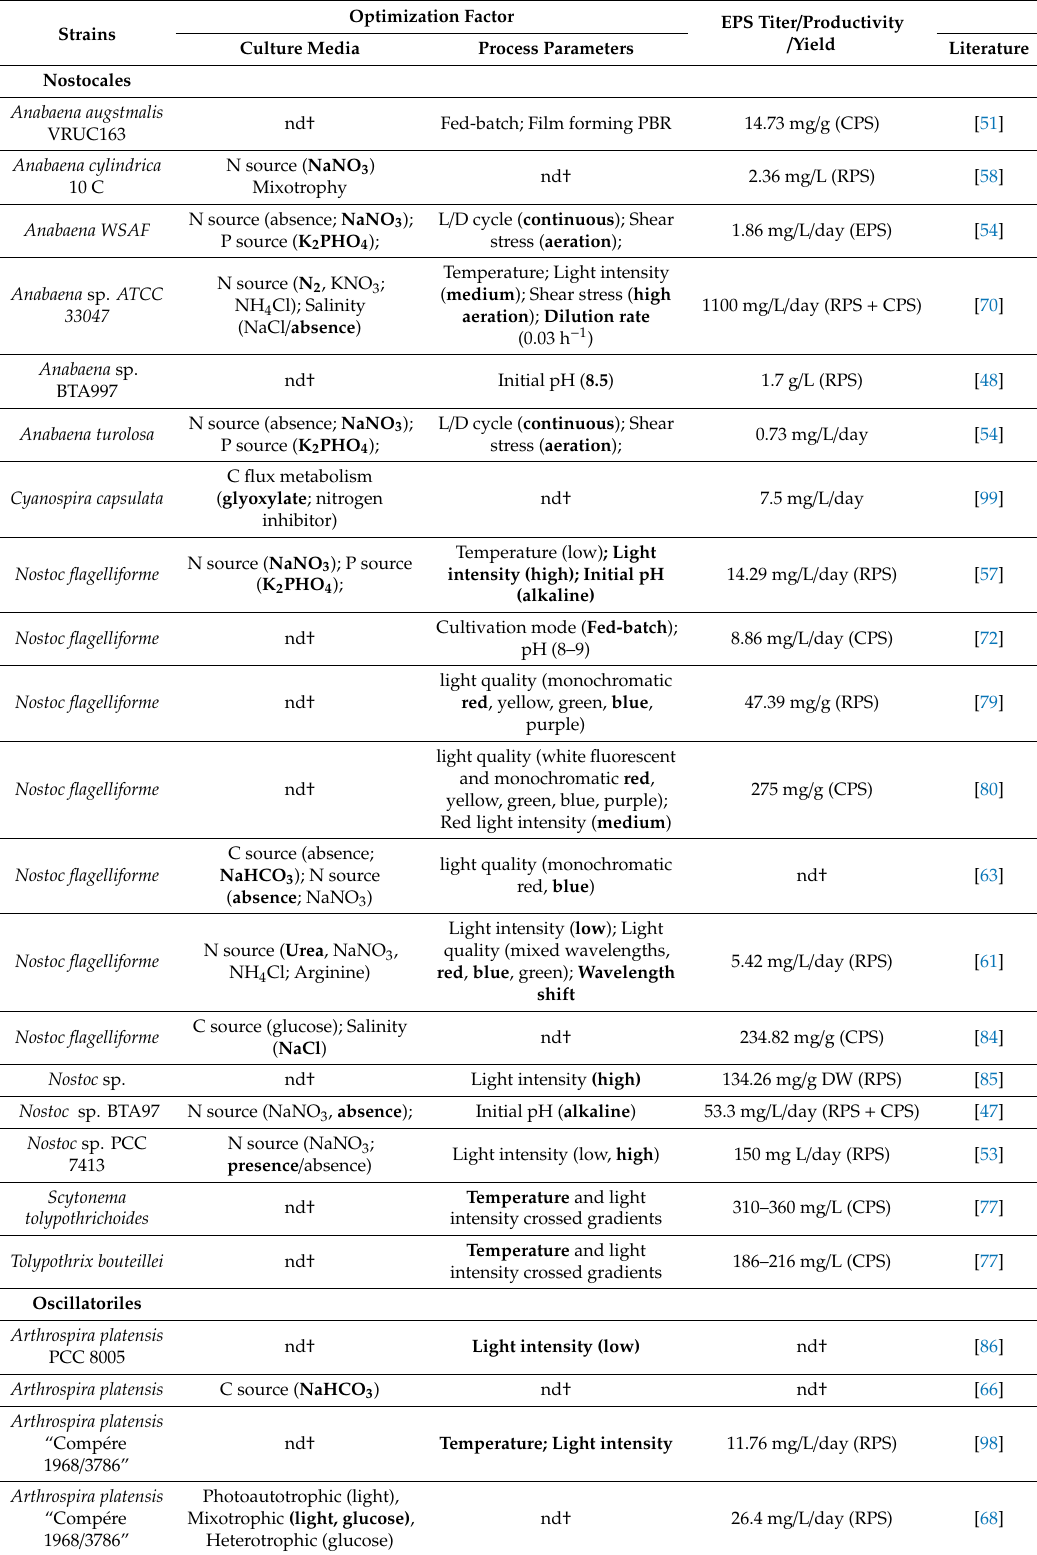
Table 3. Cyanobacterial EPS optimization studies on culture media and process parameters organized by order. Bold e ff ects correspond to positive / or significant e ff ect on EPS